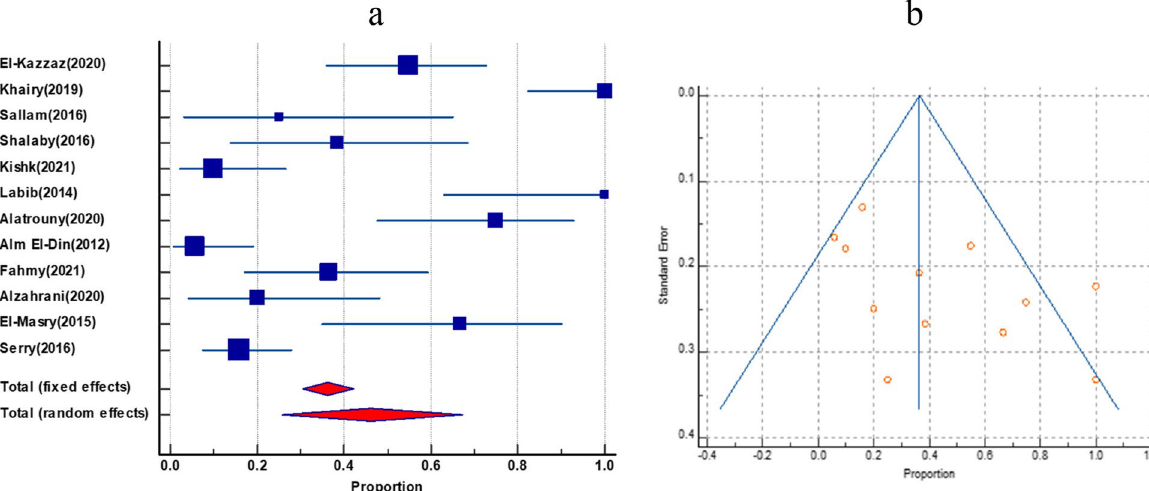
Fig. 6 The prevalence of Vancomycin-resistant E. faecium among total E. faecium. a Forest plot of Vancomycin-resistant E. faecium. b Funnel plot of Vancomycin-resistant E.